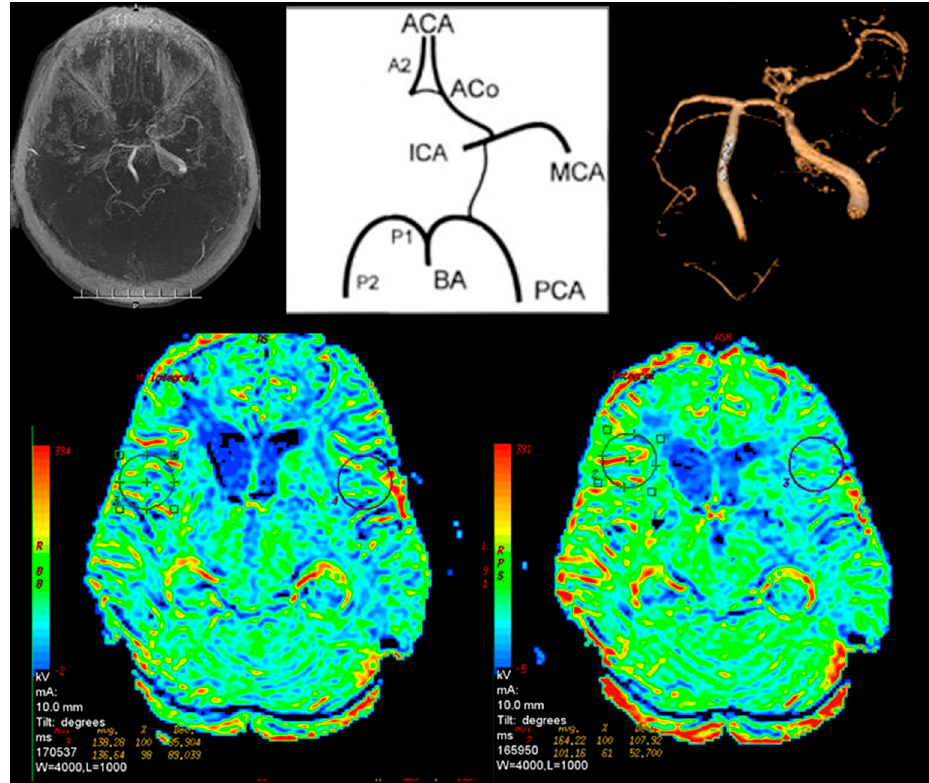
Figure 3. Magnetic resonance brain perfusion with Acetazolamide and magnetic resonance angiography of the intracranial arteries. Right internal carotid artery—100%, left internal carotid artery—70%. Differences after admission of Acetazolamide marked with circles (right side). Table 2. Distribution of pathologies in the circle of Willis in Group I and Group